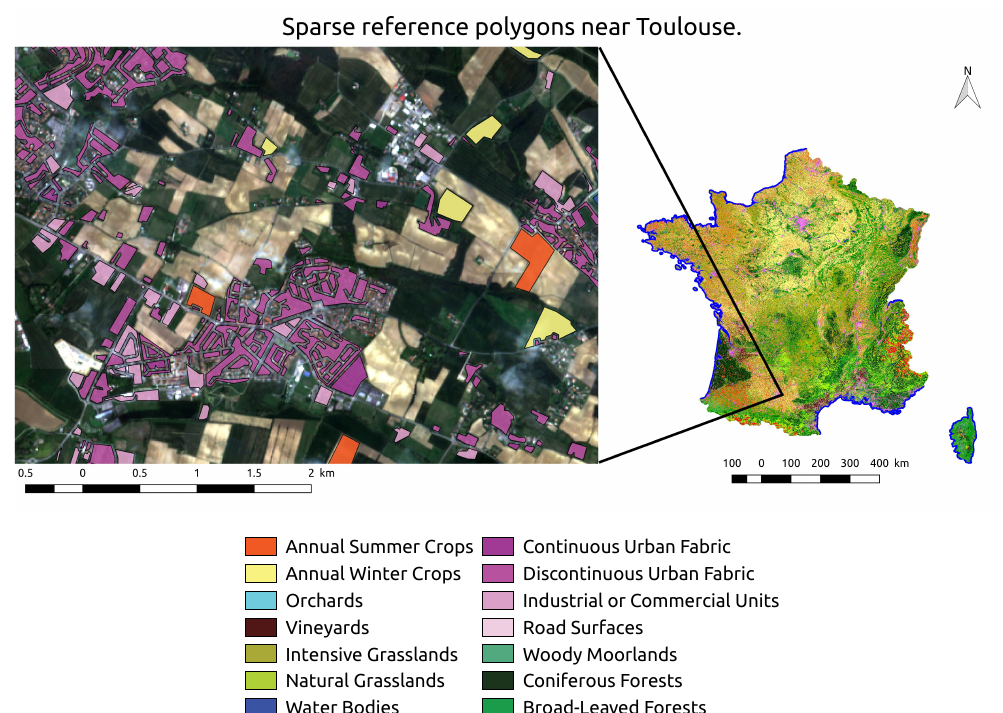
Figure 1. Example of sparse reference data used for producing and validation land cover maps, shown over the RGB bands from a Sentinel-2 image in January 2016, near the city of Toulouse in southern France. Evaluating the geometry of a classification result cannot be done directly with such validation data, as it does not contain the precise boundaries between different